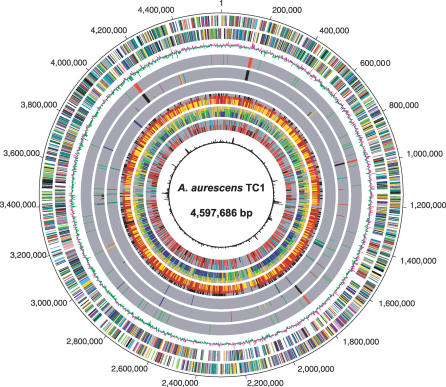
Circular Representation of the Chromosome of A. aurescens TC1Each concentric circle is numbered from the outermost circle to the inner most circle and represents genomic data for A. aurescens strain TC1 chromosome. The first and second circles represent the predicted coding sequences on the plus and minus strands, respectively, colored by functional role categories: salmon, amino acid biosynthesis; light blue, biosynthesis of cofactors and prosthetic groups and carriers; light green, cell envelope; red, cellular processes; brown, central intermediary metabolism; yellow, DNA metabolism; green, energy metabolism; purple, fatty acid and phospholipid metabolism; pink, protein fate and synthesis; orange, purines, pyrimidines, nucleosides, and nucleotides; blue, regulatory functions; grey, transcription; teal, transport and binding proteins; and black, hypothetical and conserved hypothetical proteins. The third circle displays the G + C skew: positive G + C skew in magenta and negative G + C skew in green. The fourth circle displays the rRNAs (red), sRNAs (blue), and tRNAs (green). The fifth circle displays repeated sequences of at least 50 bp long (at least 97% identity between two repeats); each color/tick size represents a different repeat. Prophage (blue ticks) and transposon (dark green ticks) genes are displayed on the sixth circle. The seventh circle displays the percentage of similarity (BLASTP searches) between TC1 and Arthrobacter sp. FB24 ORFs: >95%, full-sized black ticks; 85%–95%, three-quarter sized brown ticks; 75%–85%, three-quarter sized red ticks; 65%–75%, half-sized gold ticks; 55%–65%, half-sized yellow ticks. The eighth and ninth circles display the organism best match: L. xili (blue ticks), S. coelicolor (green ticks), and S. avermitilis (gold ticks) on circle 8. N. farcinica (red ticks), T. fusca (brown ticks), M. avium (cyan ticks), and C. efficiens (black ticks) on circle 9. The tenth circle shows the regions of atypical composition (χ2 analysis).